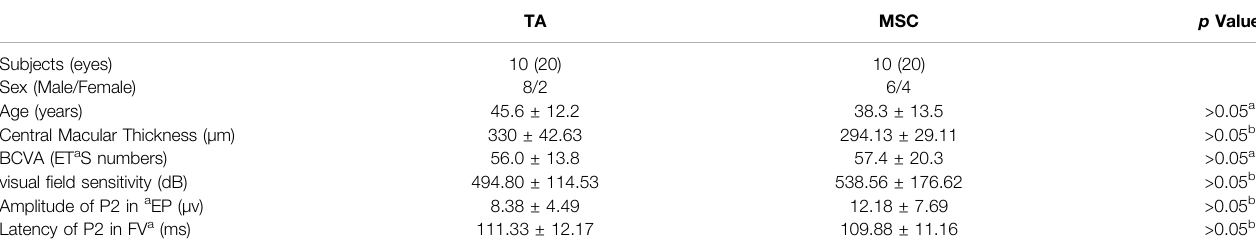
TABLE 1 | Baseline assessments of the